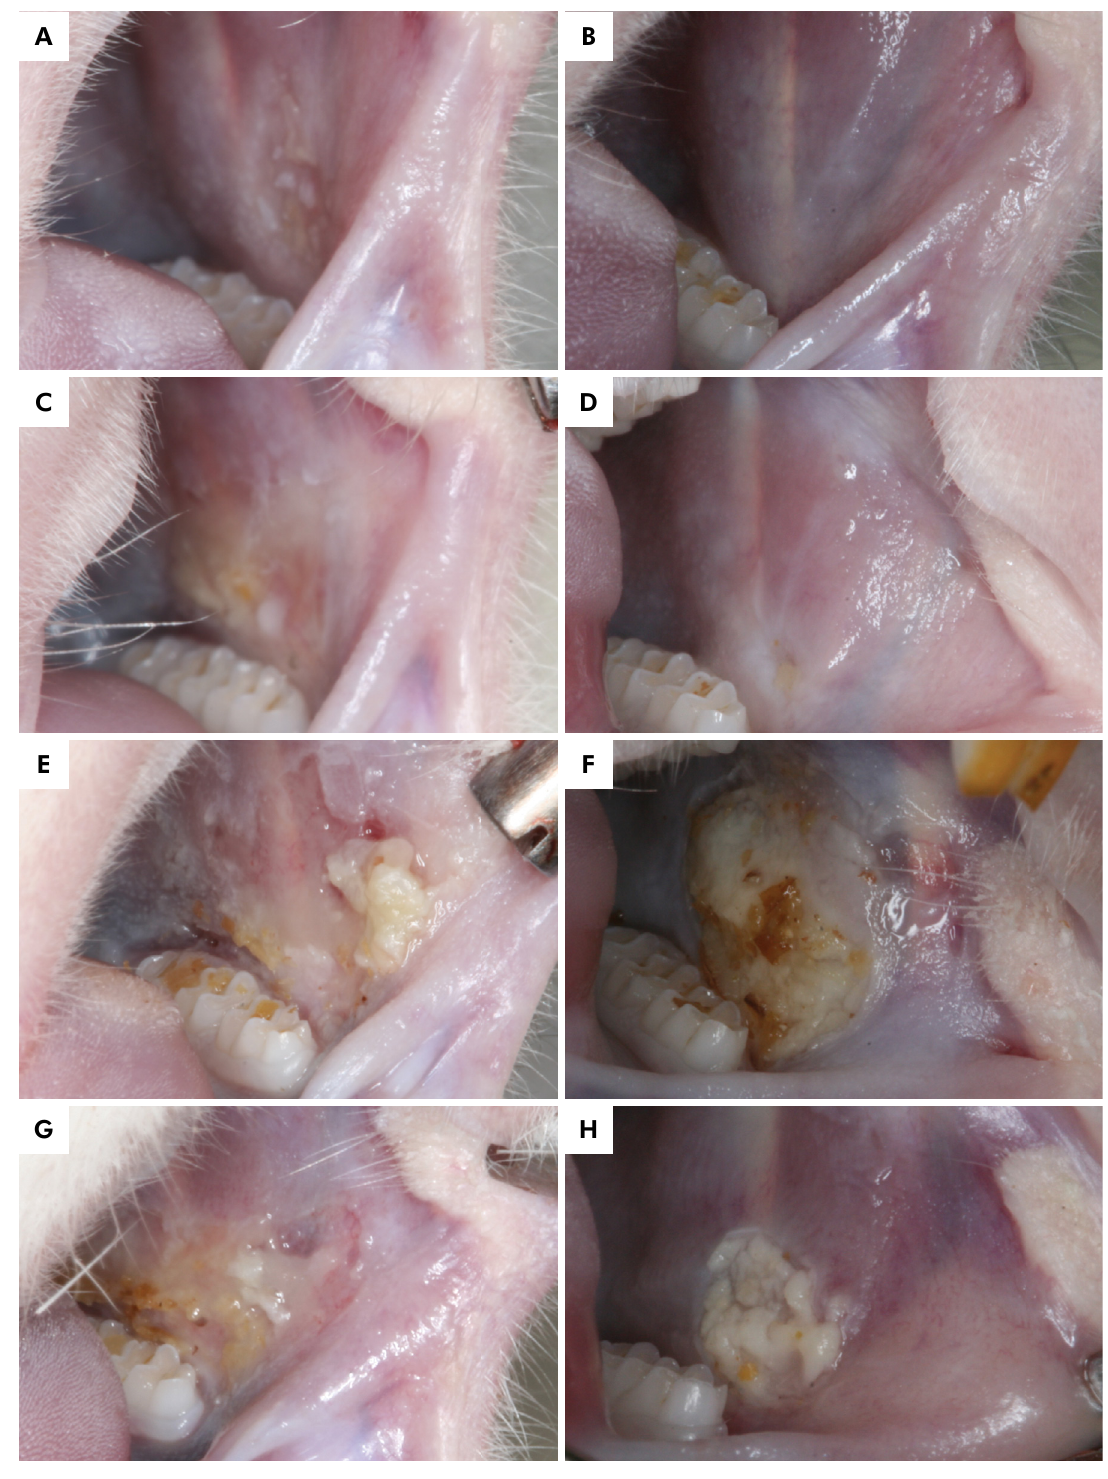
Figure 2. In groups GC and GPROB, the jugal mucosa presented discreet ulceration at day 3 (A and C), but was no longer observed at day 7 (B and D); groups G5-FU and G5-FU/PROB presented a single ulcerative lesion at day 3 (E and G), characterized as whitish, soft, of irregular shape and elevated edges, moderate erythema and hyperemia; at day 7, group G5-FU (F) presented a well-delimited lesion having severe erythema and hyperemia, and having increased in size from day 3 to 7; group G5-FU/PROB presented a reduction in the ulcerative lesion area from day 3 (G) to 7 (H), with no erythema or